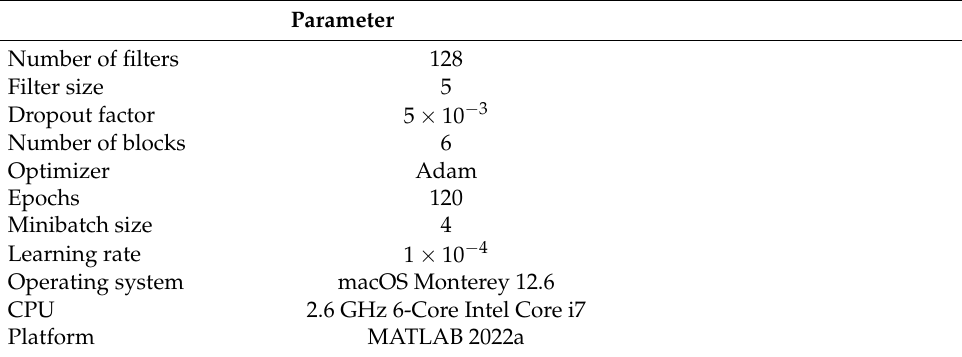
Table 2. TCN parameterization and experimental